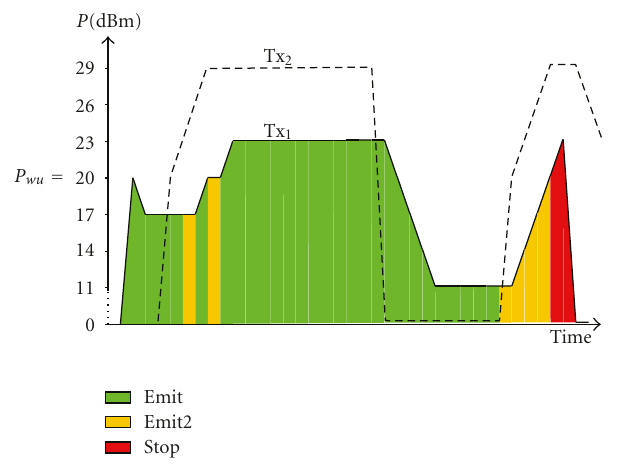
Figure 9: Transmit power versus time for the two